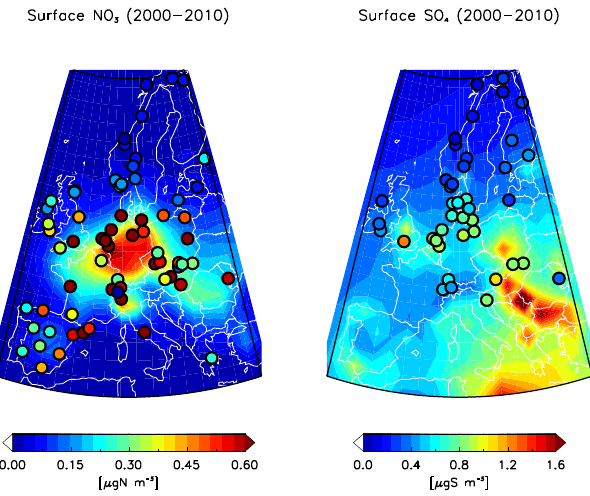
Figure 2. Mean nitrate (left panel) and sulfate (right panel) surface concentration (2000–2010) simulated by MATRIX-EQSAM over- laid by measurements from the EMEP network. The model data units match the units of the measured data (µg X m − 3 with X being N for nitrate and S for sulfate). Table 1. Regional boundaries for data division. Region Boundaries